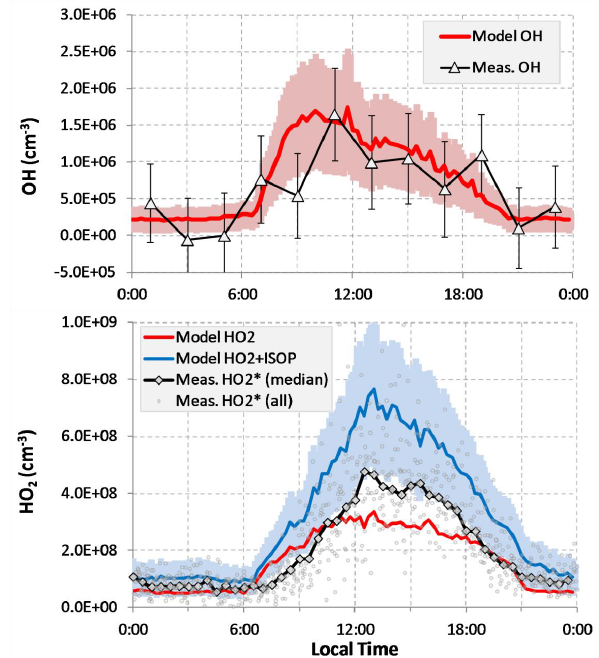
Figure 7: CABINEX 2009 OH and HO 2 * median measurements with the RACM/MIM model results. Measured points are shown as 2 hr medians (OH, triangles) and 30 min medians (HO 2 *, diamonds). Error bars are the 2-sigma measurement precision for OH, while the HO 2 * measurement precision (not shown) is ± 1.5 × 10 7 cm -3 . Gray points in the bottom plot represent the entire above canopy HO 2 * measurements during CABINEX 2009. The red lines represent the base RACM/MIM model results for OH (2σ relative uncertainty ±32% shaded) or HO 2 . The blue lines represent the modeled HO 2 + ISOP (2σ relative uncertainty ± 30% and ± 41% shaded for day and night).